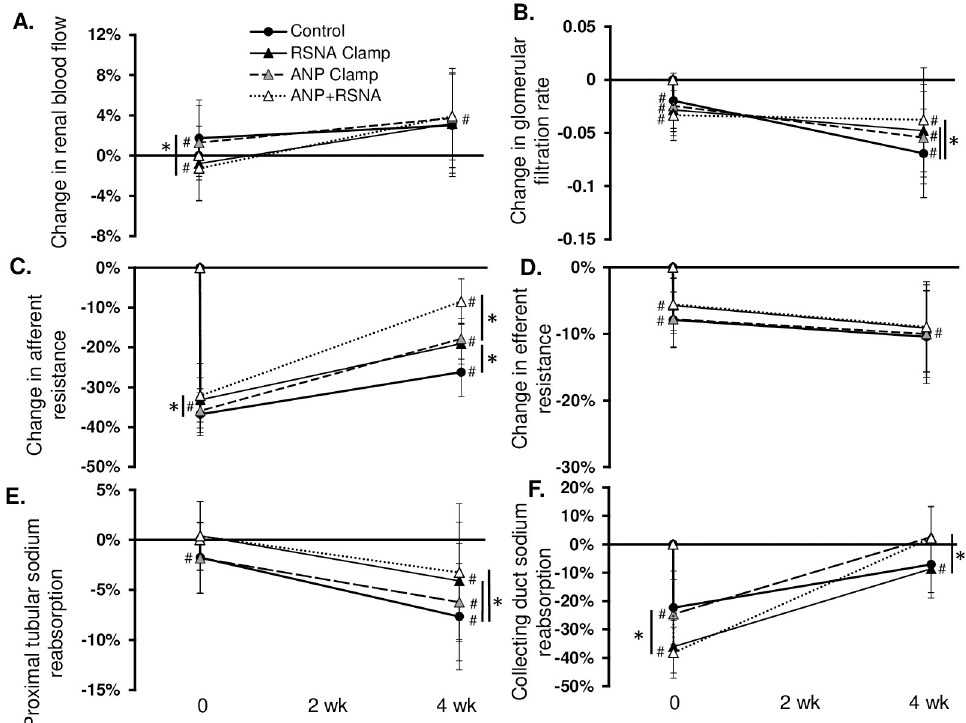
Fig 6. Changes in renal function during BAT in the control, RSNA Clamp, ANP Clamp, and ANP+RSNA Clamp simulations. � p < 0.05; #p < 0.05 vs. baseline.